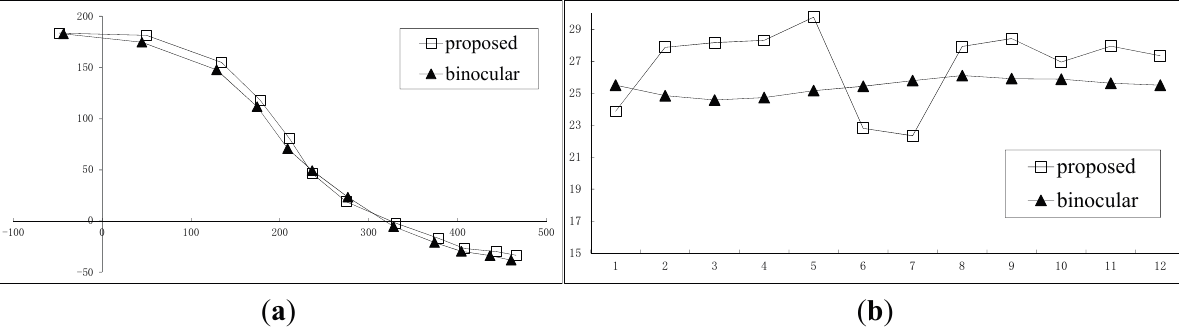
Figure 5. The results of 2D reconstruction. ( a ) XOY plane; ( b ) Z direction over the